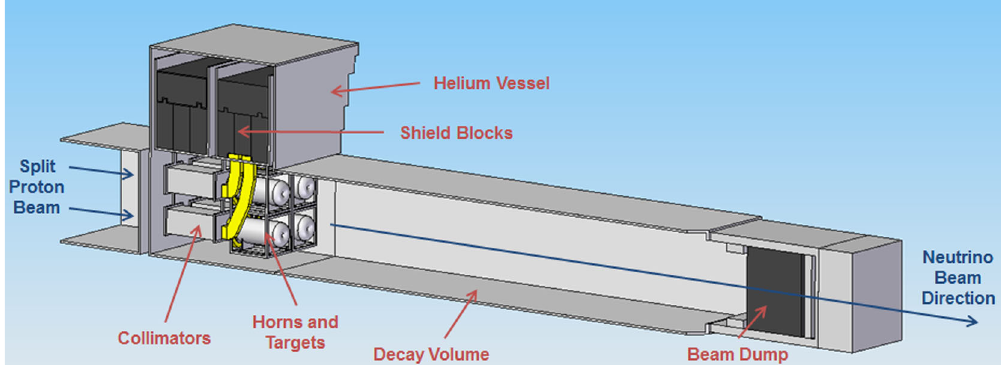
FIG. 4. Components of the target station, decay volume, and beam